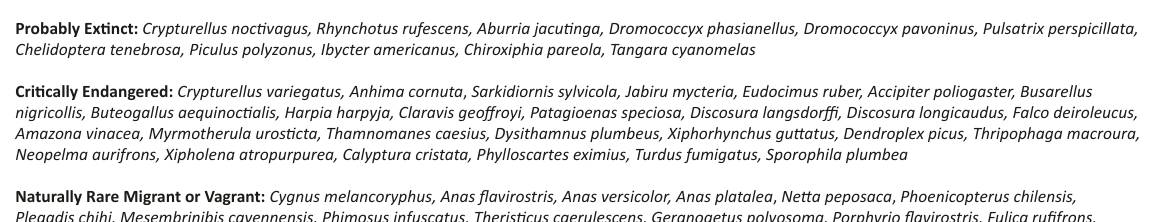
Table 2. Local conservation status of the rarest bird species in the state of Rio de Janeiro. Extinct: Crax blumenbachii*, Morphnus guianensis, Neomorphus geoffroyi, Monasa morphoeus, Micrastur mintoni, Ara ararauna, Ara chloropterus, Cotinga maculata, Sporophila maximiliani Probably Extinct: Crypturellus noctivagus, Rhynchotus rufescens, Aburria jacutinga, Dromococcyx phasianellus, Dromococcyx pavoninus, Pulsatrix perspicillata, Chelidoptera tenebrosa, Piculus polyzonus, Ibycter americanus, Chiroxiphia pareola, Tangara cyanomelas Critically Endangered: Crypturellus variegatus, Anhima cornuta , Sarkidiornis sylvicola, Jabiru mycteria, Eudocimus ruber, Accipiter poliogaster, Busarellus nigricollis, Buteogallus aequinoctialis, Harpia harpyja, Claravis geoffroyi, Patagioenas speciosa, Discosura langsdorffi, Discosura longicaudus, Falco deiroleucus,